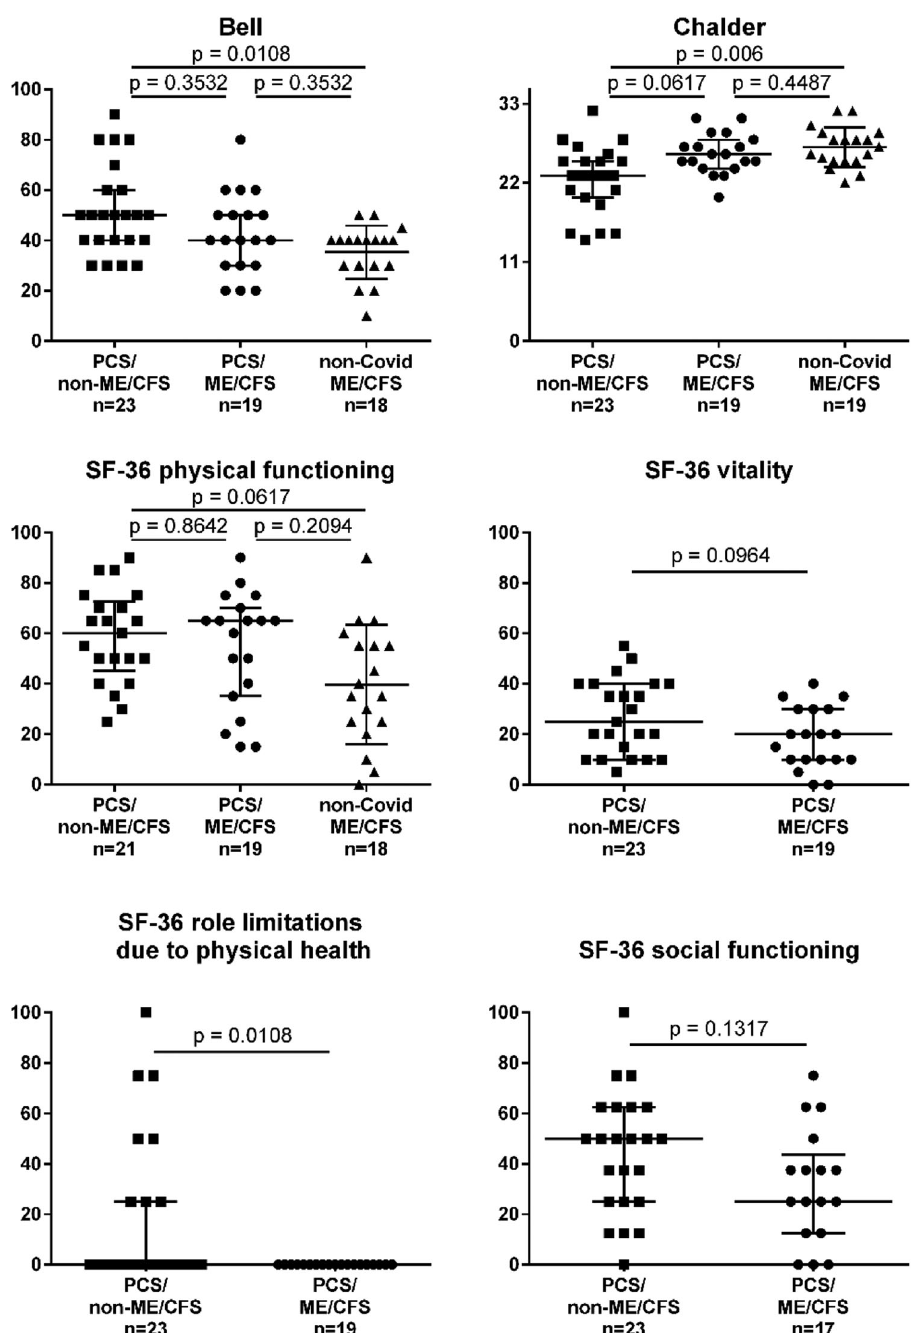
Fig. 1 | Severity of fatigue and disability. PCS/non-ME/CFS post-COVID-19 syn- drome/non-myalgic encephalomyelitis/chronic fatigue syndrome; PCS/ME/CFS post-COVID-19 syndrome/myalgic encephalomyelitis/chronic fatigue syndrome; non-COVID ME/CFS non-COVID-19 myalgic encephalomyelitis/chronic fatigue syndrome; PEM post-exertional malaise; CFQ Chalder fatigue scale; SF-36 36-Item ShortFormSurvey.Belldisabilityscale(score0 – 100),CFQ(score0 – 33),andSF-36 physicalfunction, vitality, rolelimitations, and socialfunction (scores 0 – 100)were